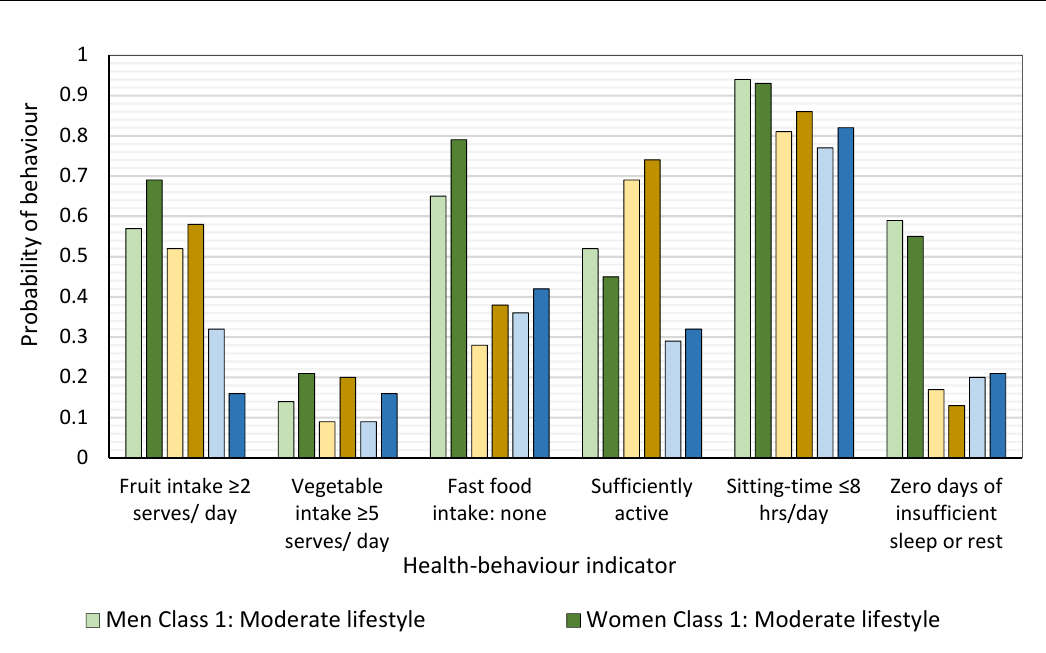
Figure 1. Item-response probability plot for men and women by health behavior class. The probability of each health-behaviour in each of the three behaviour classes ‘moderate lifestyle’, ‘active poor sleeper’, and ‘poor lifestyle’ (alternating bars for men and women).